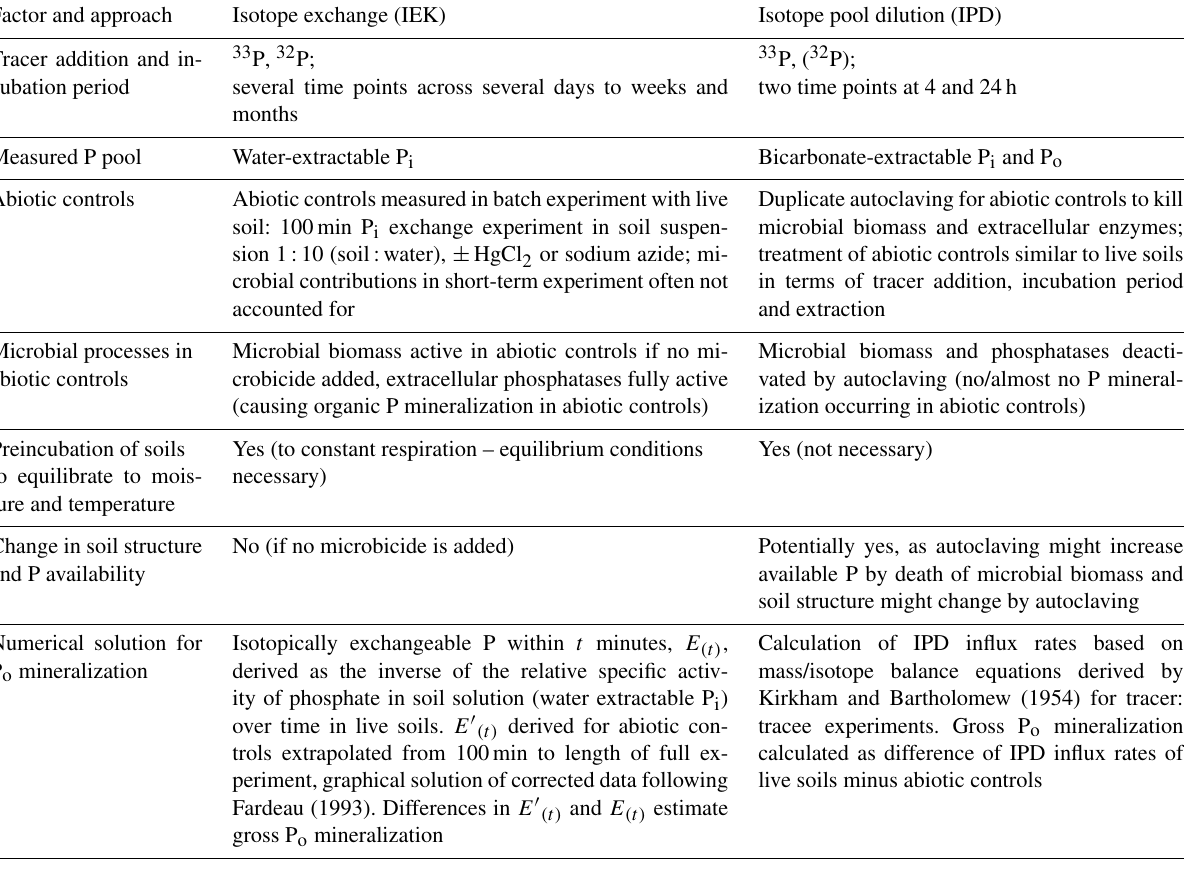
Table 1. Comparison of traditional isotope exchange kinetic kinetic (IEK) experiments and the novel isotope pool dilution (IPD) approach to measure organic P